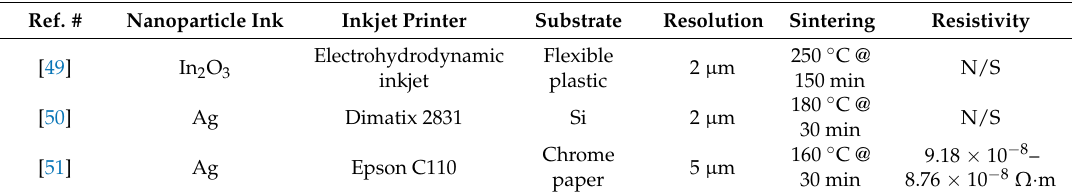
Table 5. Best resolution achieved using various inkjet-printing machines. Ref.